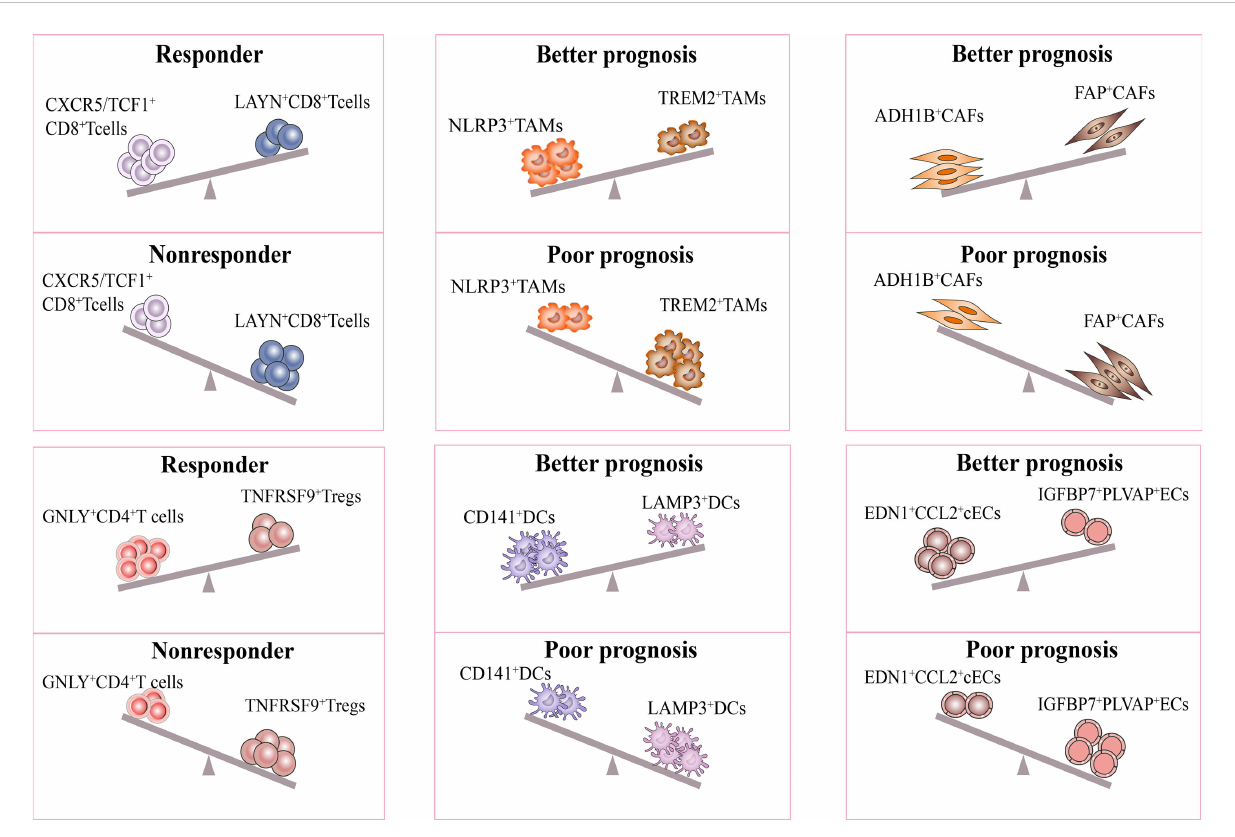
FIGURE 3 Response of immunotherapy treatment of lung cancer for distinct subsets. The fi gure describes in fl uence of the distinct stromal cell phenotypes in TME on responsiveness to immunotherapy and therapeutic ef fi cacy of treatment. The CXCR5/TCF-1 + CD8 + T and GNLY + CD4 + T subsets were signi fi cantly more abundant in immune responders than in non-responders. Moreover, the ratio of NLRP3 + /TREM2 + TAMs, CD141 + /LAMP3 + DCs, ADH1B + /FAP + CAFs, EDN1 + CCL2 + cECs/IGFBP7 + PLVAP + ECs were positively correlated with better prognosis in lung cancer. All the above subsets may be potential targets for lung cancer